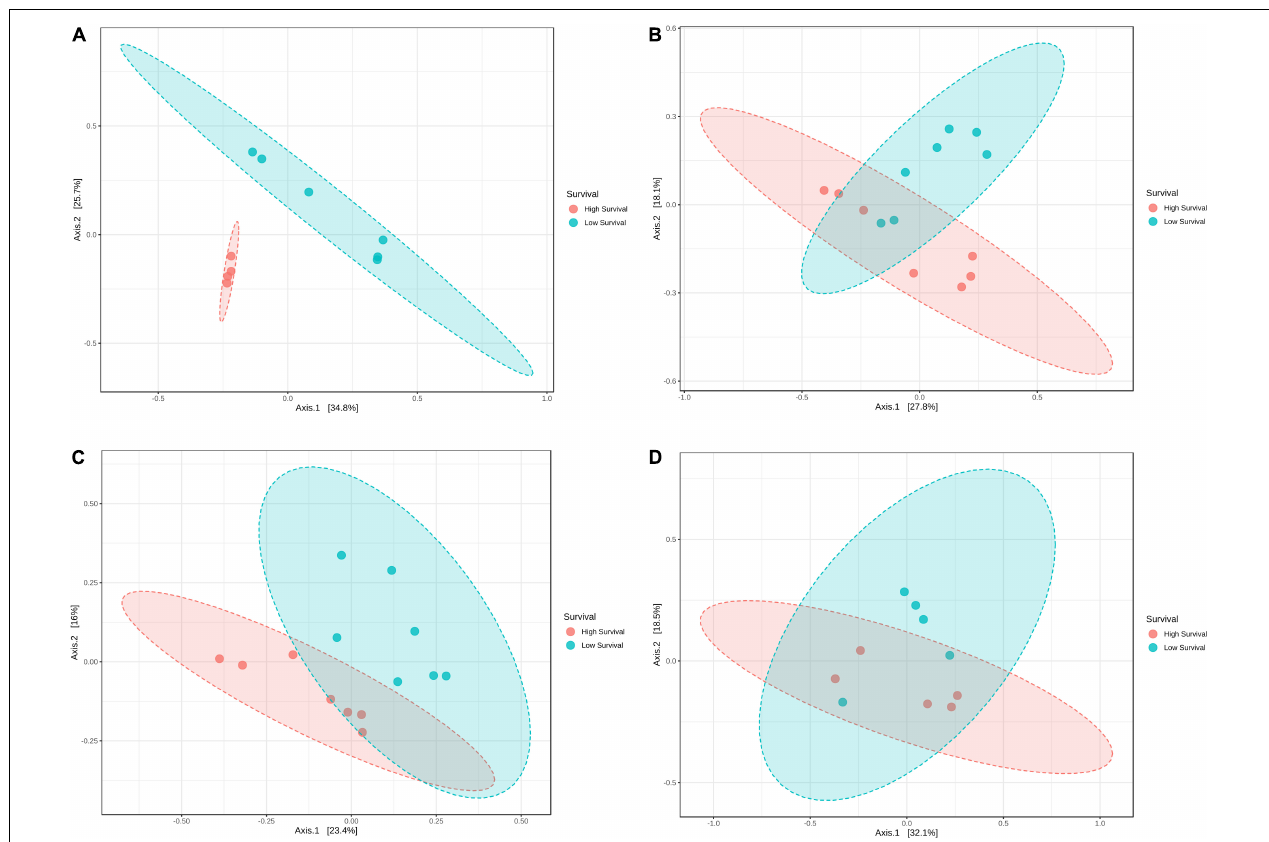
FIGURE 5 | Principal coordinate analysis (PCoA) of the Bray–Curtis dissimilarity index from larvae collected at the high- and low-survival tanks affected with AHPND. (A) Mysis 3. (B) Postlarvae 4. (C) Postlarvae 7. (D) Postlarvae